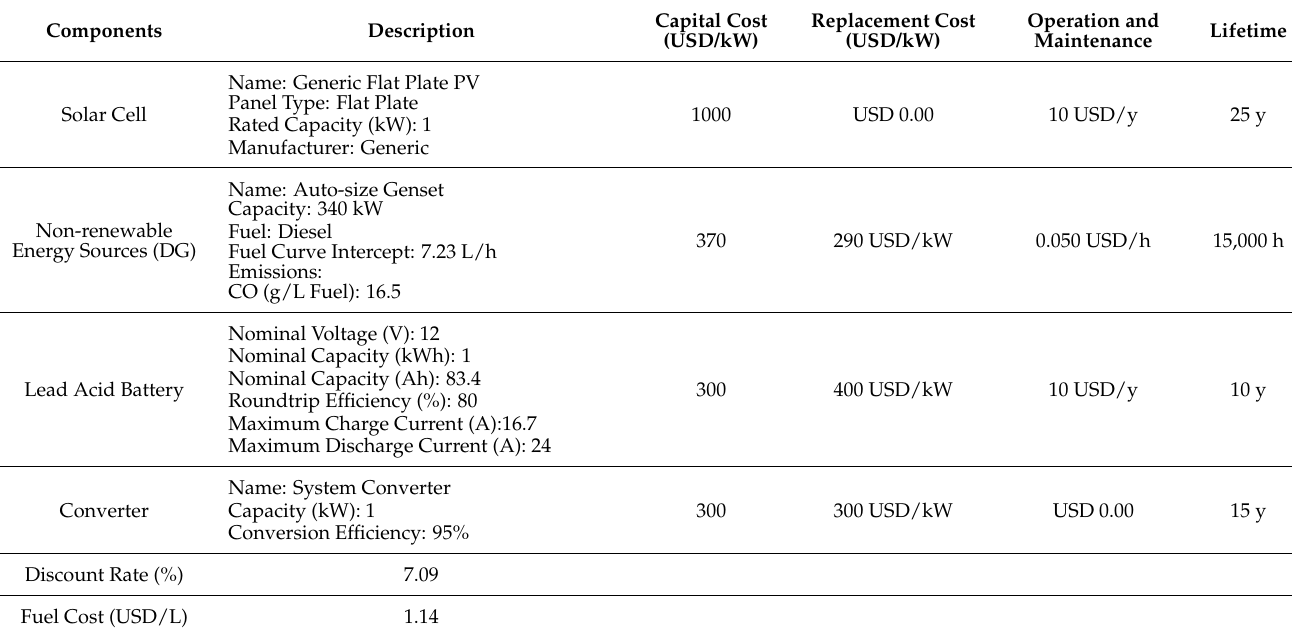
Table 7. Data about the technical and financial aspects of the embedded